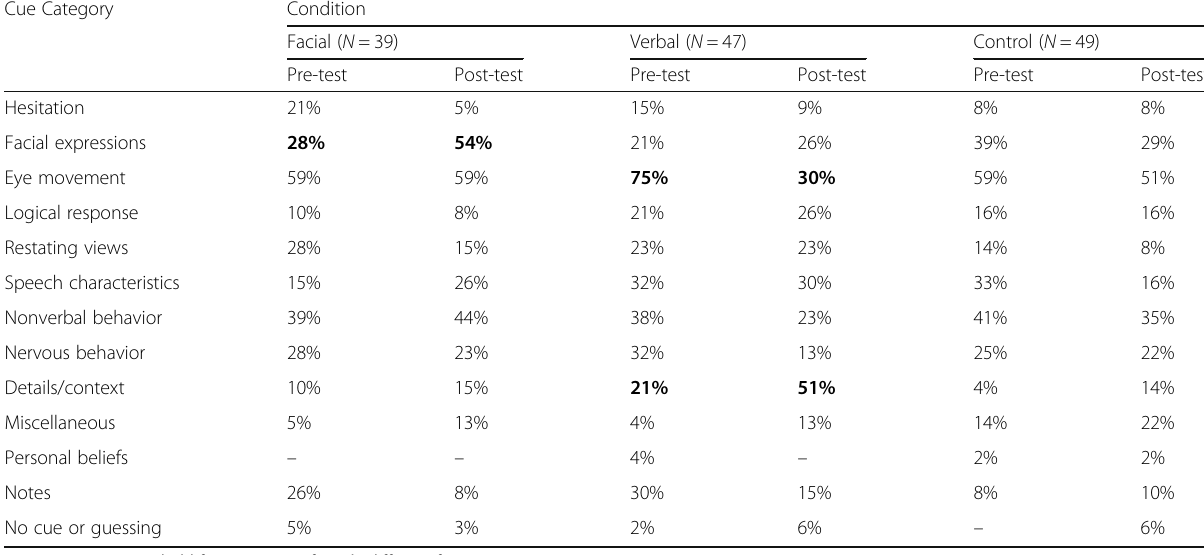
Table 2 Frequency of cues mentioned by condition Cue Category